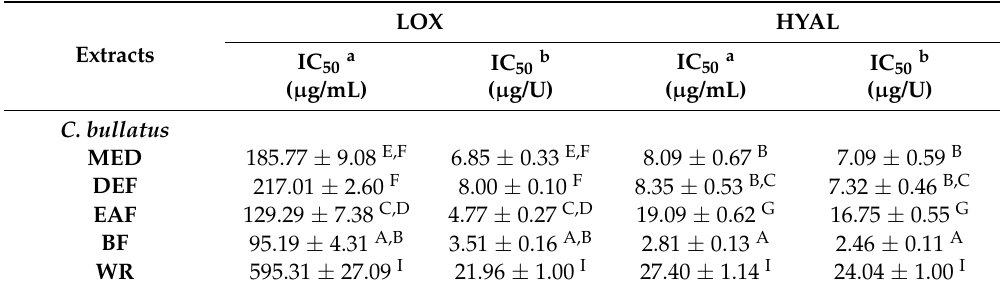
Table 3. Inhibitory effects of Cotoneaster leaf extract and standards on lipoxygenase (LOX) and hyaluronidase